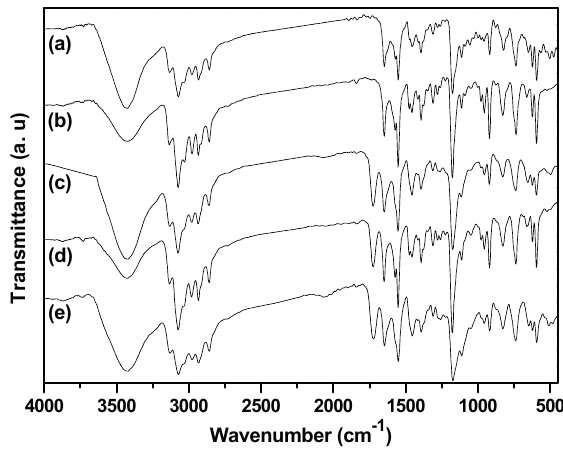
Figure 6. FTIR spectra of BIm-based nanogels with different monomers and feed ratio. (( a ) [C 6 VIm]Br:DVB = 5:1; ( b ) [C 6 VIm]Br:DVB = 10:1; ( c ) [C 6 VIm]Br:EGDMA = 10:1; ( d ) [C 8 VIm]Br:EGDMA = 10:1; ( e ) [C 12 VIm]Br:EGDMA = 10:1).